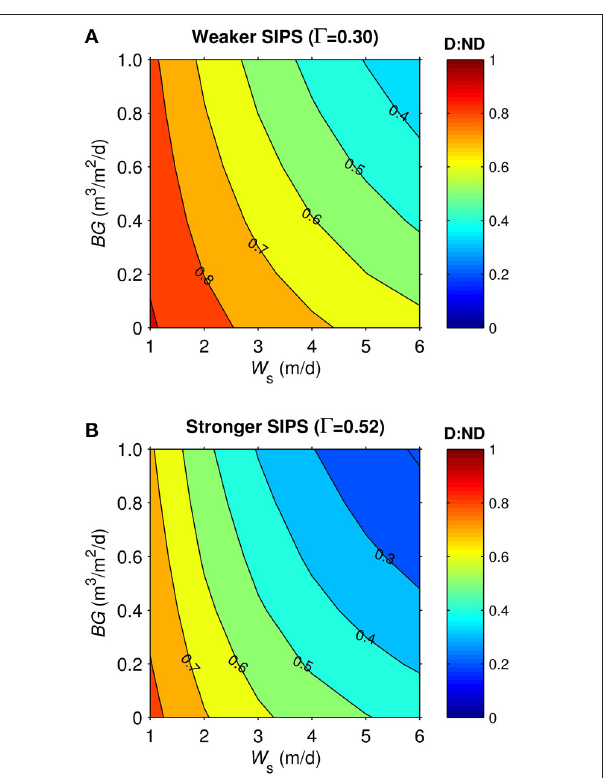
FIGURE 9 | Diatom:non-diatom ratios (D:ND) for generic shoal. D:ND is based on computed diatom and non-diatom biomass in 2.5m deep shoal at 7 simulation days and is shown for multiple combinations of benthic grazing rate ( BG ) and diatom sinking speed ( W s ). (A) generic shoal SIPS case with longitudinal salinity gradient Γ = 0. 30km − 1 (weaker tidal-scale stratification, see Table 3 ), (B) generic shoal SIPS case with longitudinal salinity gradient Γ = 0. 52km − 1 (stronger tidal-scale